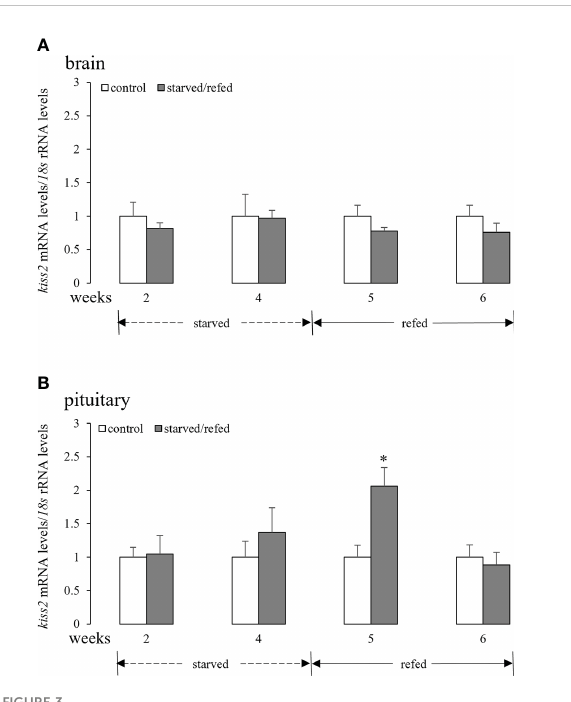
FIGURE 2 Effects of nutritional status on the brain (A) and pituitary (B) lpxrfa-r mRNA levels in half-smooth tongue sole. Data were normalized against 18s transcripts and are presented as mean ± SEM (n = 4). A star indicates signi fi cant difference between fed and starved/refed groups ( p < 0.05).